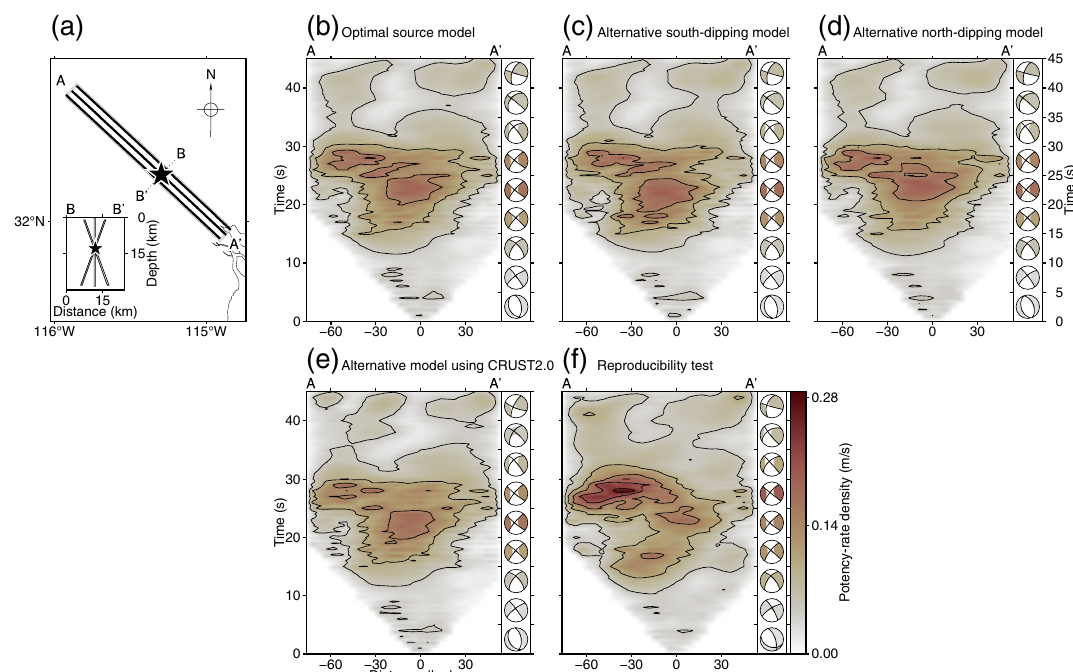
Figure 6. Summary of sensitivity and reproducibility test results. ( a ) Schematic map of the study area. The lines indicate the top of the model planes. The star is the epicentre used for the inversion. The inset shows a cross section along B–B ′ , and the lines show the model domains. In ( b – f ), potency-rate density evolution (contour interval 0.05 m/s) is projected along A–A ′ ; distance is relative to the epicentre. ( b ) Our optimal solution obtained using a vertical model plane (i.e. the same as Fig. 2d). ( c ) The solution obtained using a plane dipping 70° southwest (strike 133°). ( d ) The solution obtained using a plane dipping 70° northeast (strike 313°). ( e ) The solution obtained using a vertical plane and the CRUST2.0 model 43 . ( f ) The solution obtained by inverting synthetic waveforms using our optimal solution as input. Beachballs to the right of each panel show the total moment tensors obtained in 5 s time windows. Note that the beachballs are shown as lower hemisphere projections onto the map with north upward. This figure was made with Generic Mapping Tools (v6.2.0) 18